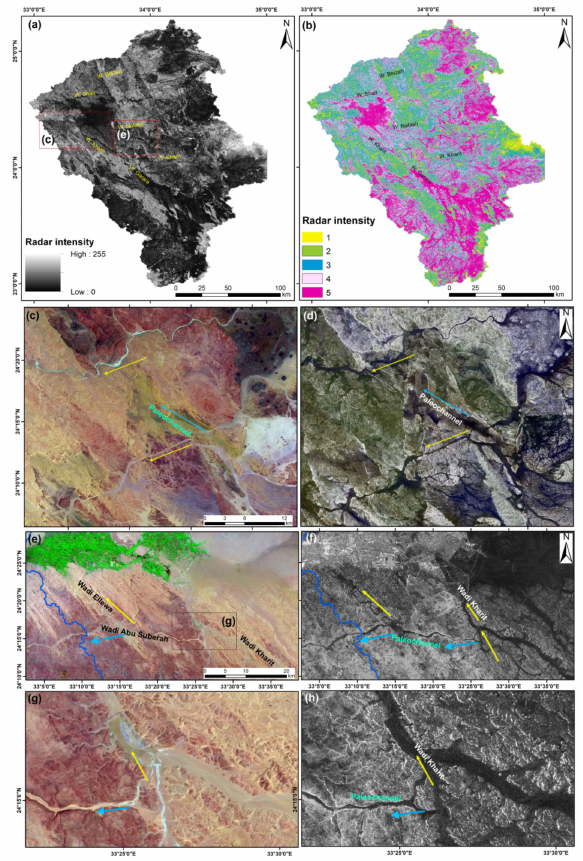
Figure 9. ( a ) ALOS/PALSAR of the study area; ( b ) radar density map of the physical properties of the soil using ALOS/PALSAR data; ( c ) Landsat-8 of downstream of W. Kharit. Yellow arrows reveal the present westward flow and the past NW outlet, as shown in the cyan arrow, that are revealed by a fused ALOS/PALSAR and Landsat-8 image in ( d ); ( e , f ) downstream area of W. Kharit showing the SW flow that was captured by the NW flow, as depicted by the yellow arrow (present flow) and cyan arrow (past flow) in ( g , h